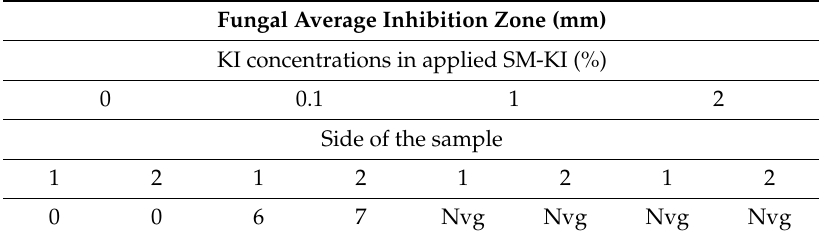
Table 8. Results of tests on the antifungal activity of modified